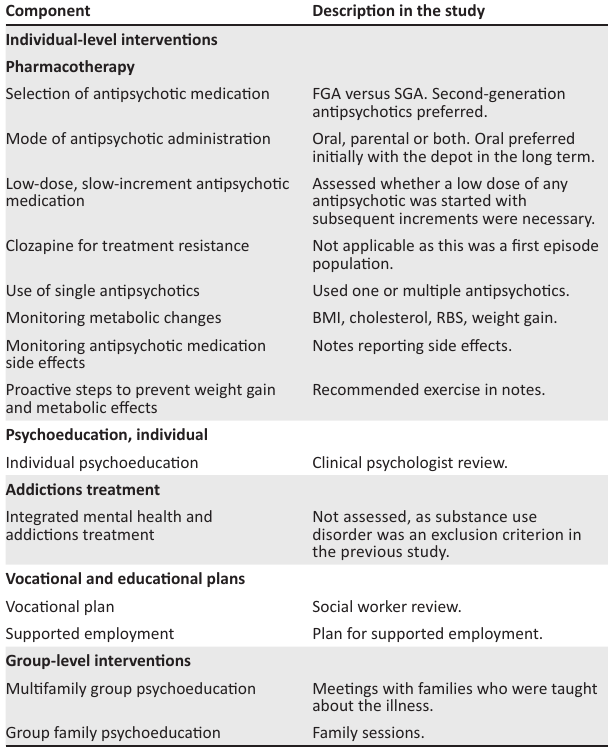
TABLE 2: Summary of how the essential, evidence-based components for specialised early intervention services were assessed in the study.